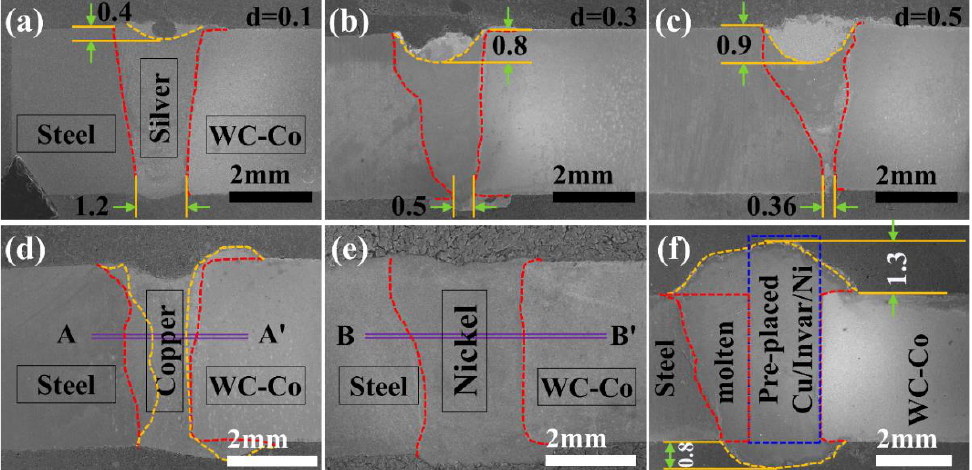
Figure 5. Cross-sectional view of a typical joint of S1045 (left side) and WC Co (right side) ( a ) Specimen B 1 , d = 0.1 mm, ( b ) Specimen B 2 , d = 0.3 mm, ( c ) Specimen B 3 , d = 0.5 mm, using silver as brazing filler metal. ( d ) Specimen A 4 , d = 0.5 mm, using copper as brazing filler metal. ( e ) Specimen C 2 , d = 0.3 mm, using nickel as brazing filler metal ( f ) Specimen V 2 , using Cu/Invar/Ni as brazing filler